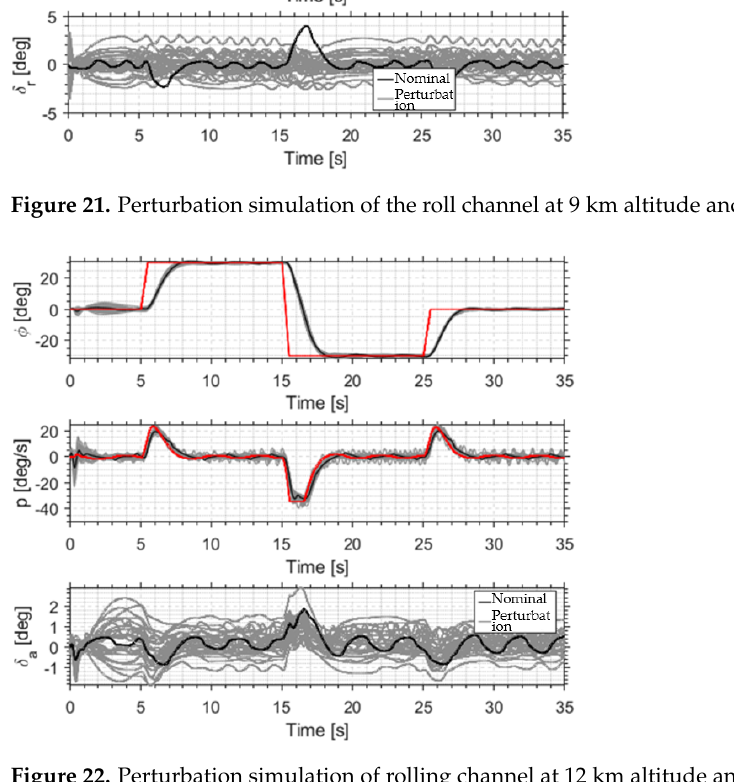
Figure 22. Perturbation simulation of rolling channel at 12 km altitude and 1.2 Mach number.